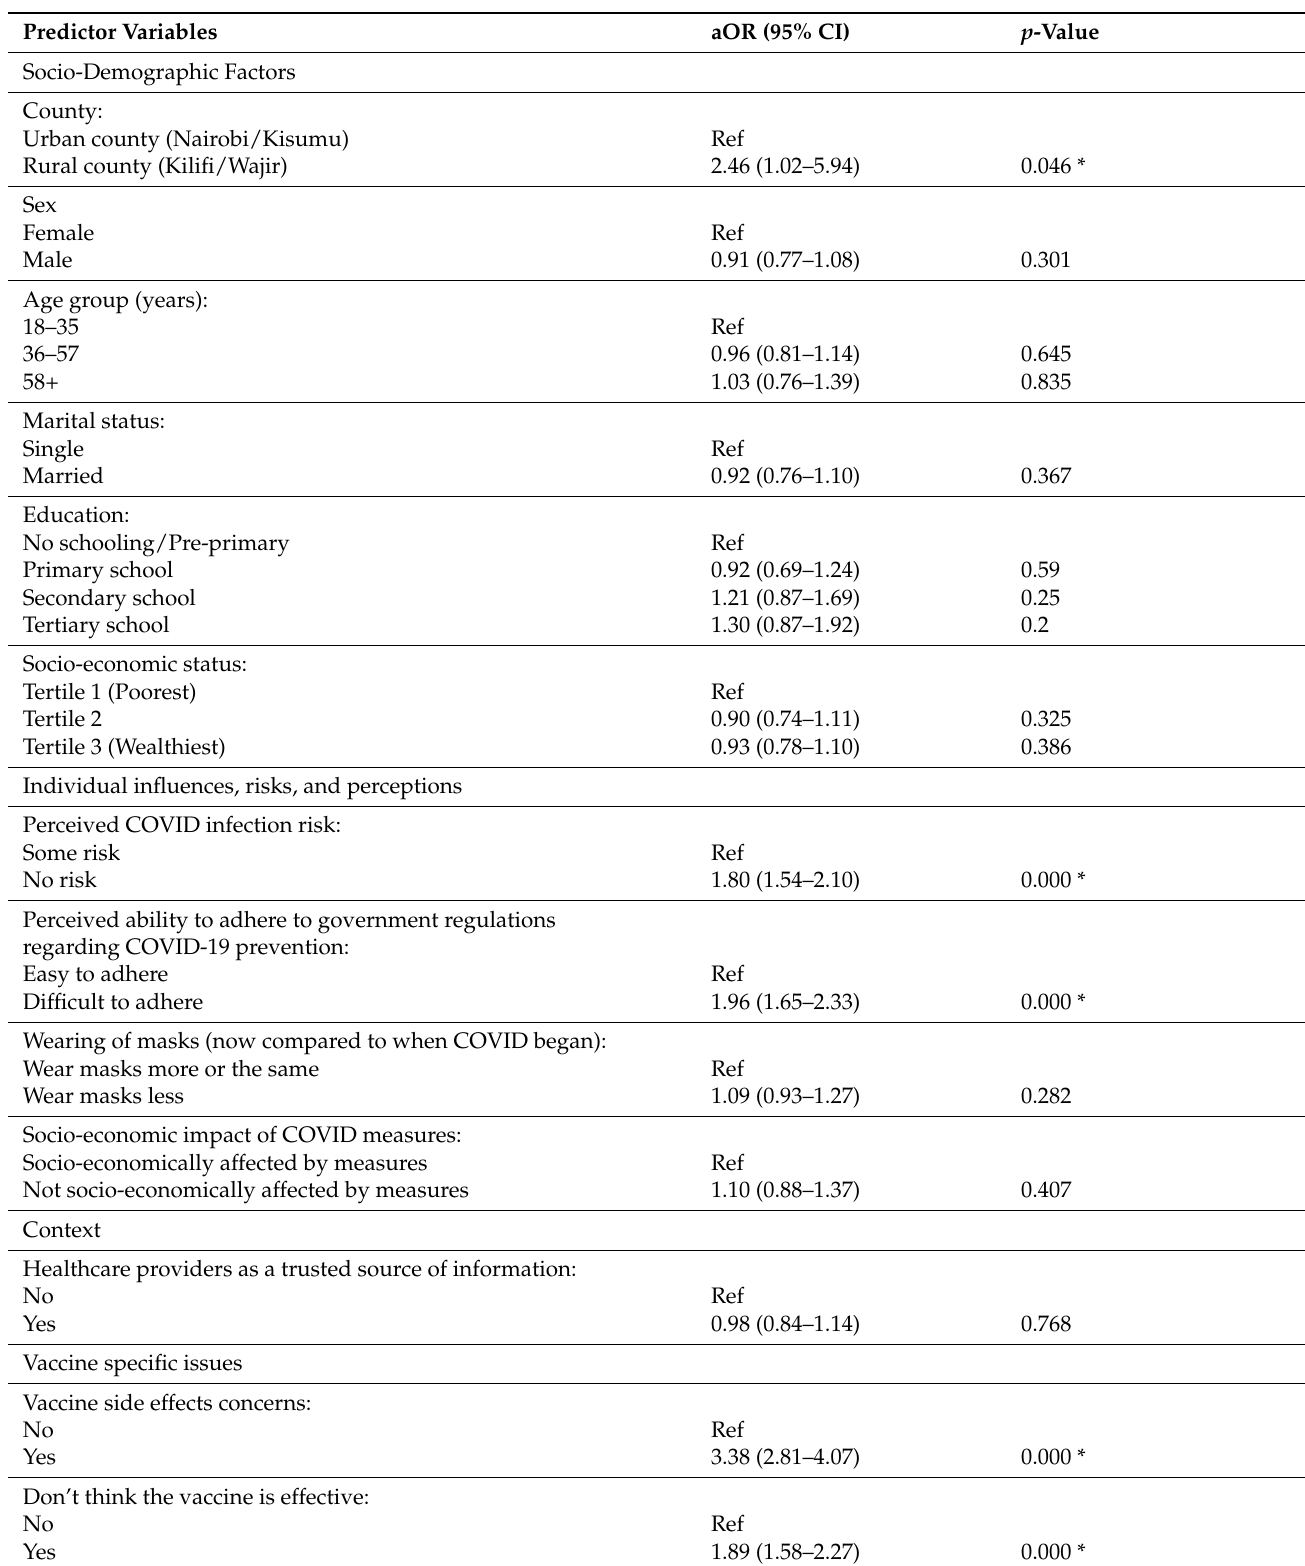
Table 4. Multilevel logistic regression analysis for factors potentially associated with COVID-19 vaccine hesitancy among respondents in